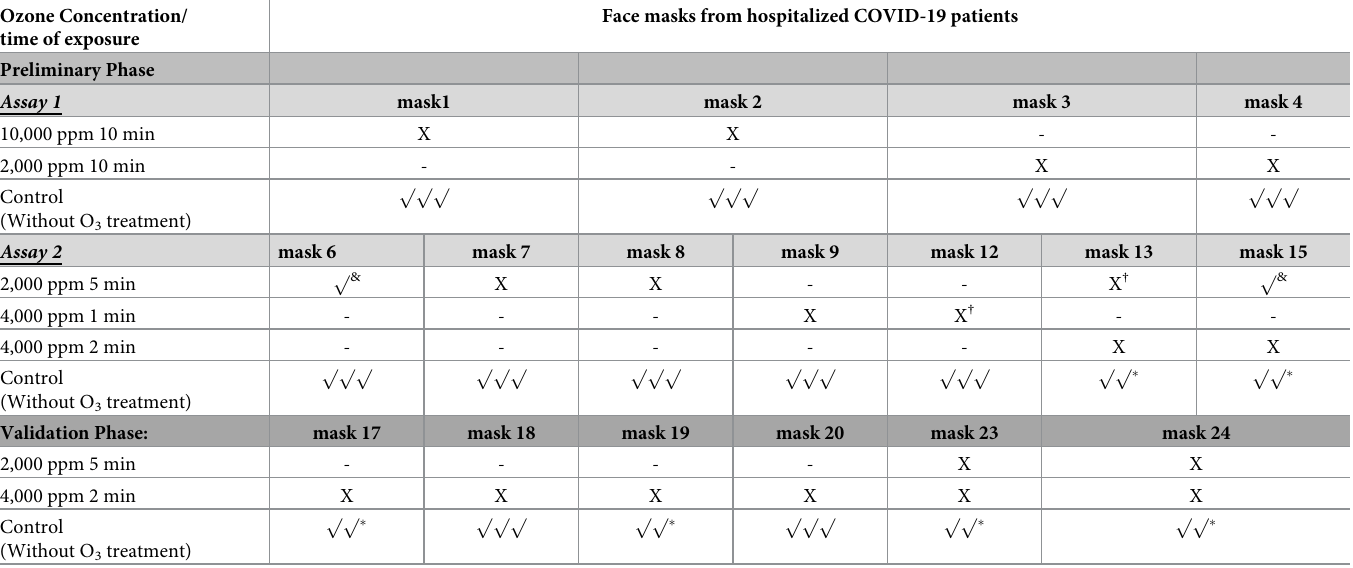
Table 1. Gene amplification by quantitative real-time polymerase chain reaction (RT-qPCR) in VERO cell lysates infected with FFP2 samples and treated at differ- ent ozone concentrations and exposure